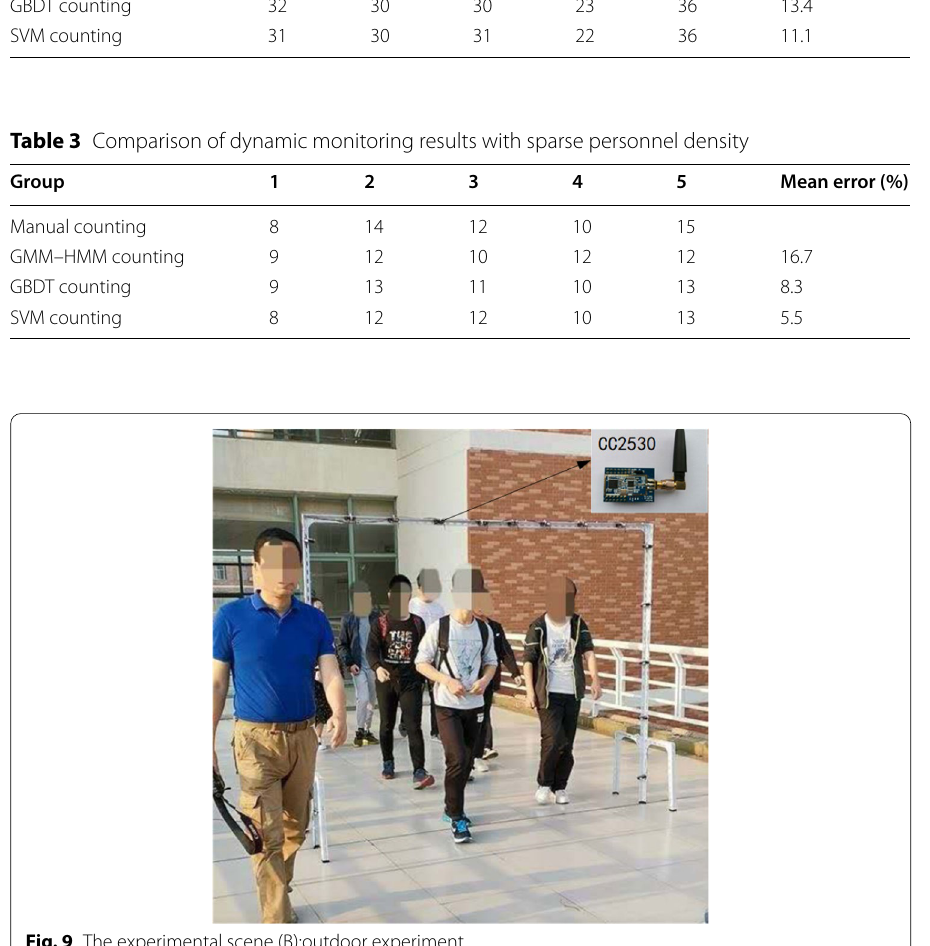
Fig. 9 The experimental scene (B):outdoor